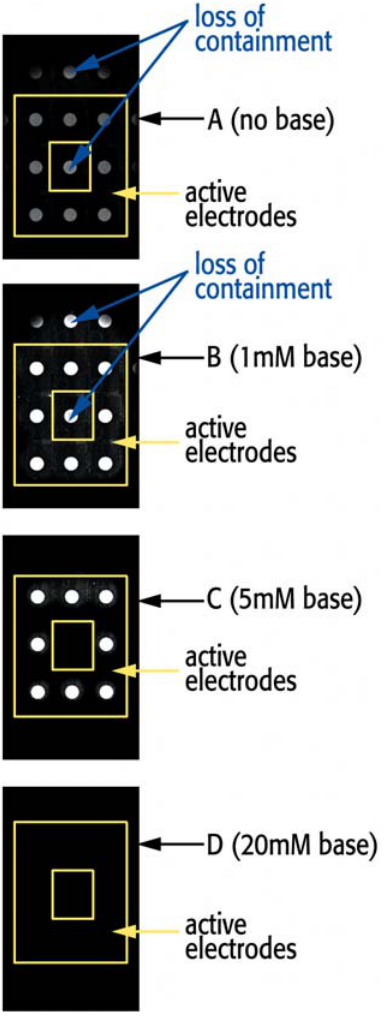
Figure 5. Example of a portion of an array demonstrating a voltage study from 1.2 to 2.4 V.